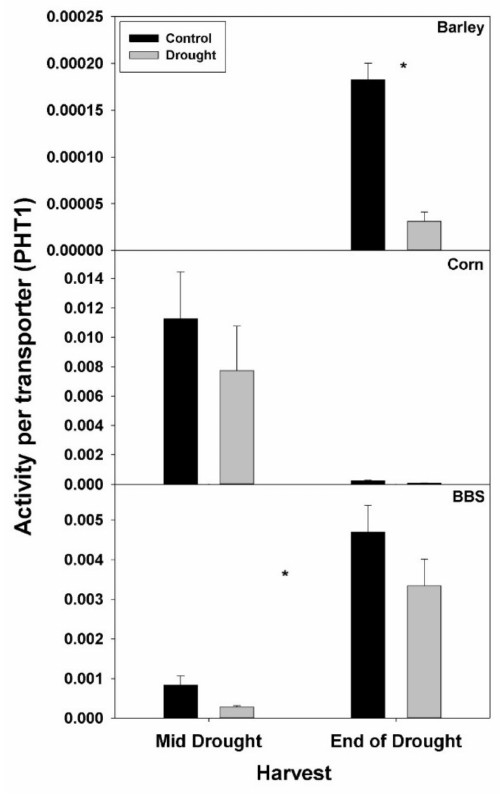
Figure 8. Effects of control vs. drought treatments on the relative activity of the phosphate-uptake protein, PHT1, of roots in barley, corn, and big bluestem (BBS). Each bar represents mean + 1 SE (standard error). Within each panel, bars not sharing the same letters are significantly different. For each response variable, significant effects of drought (ANOVA), across both harvest in corn and big bluestem, are indicated with an asterisk